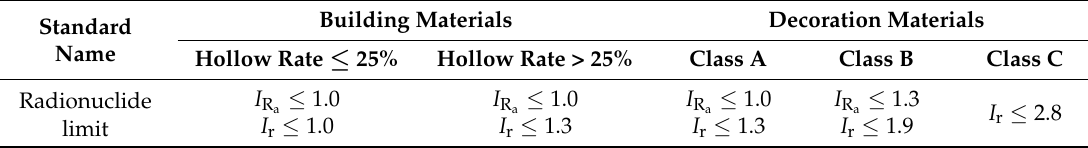
Table 7. Limited Standards for the Radionuclide of Building Materials (GB/6566-2010) [43].